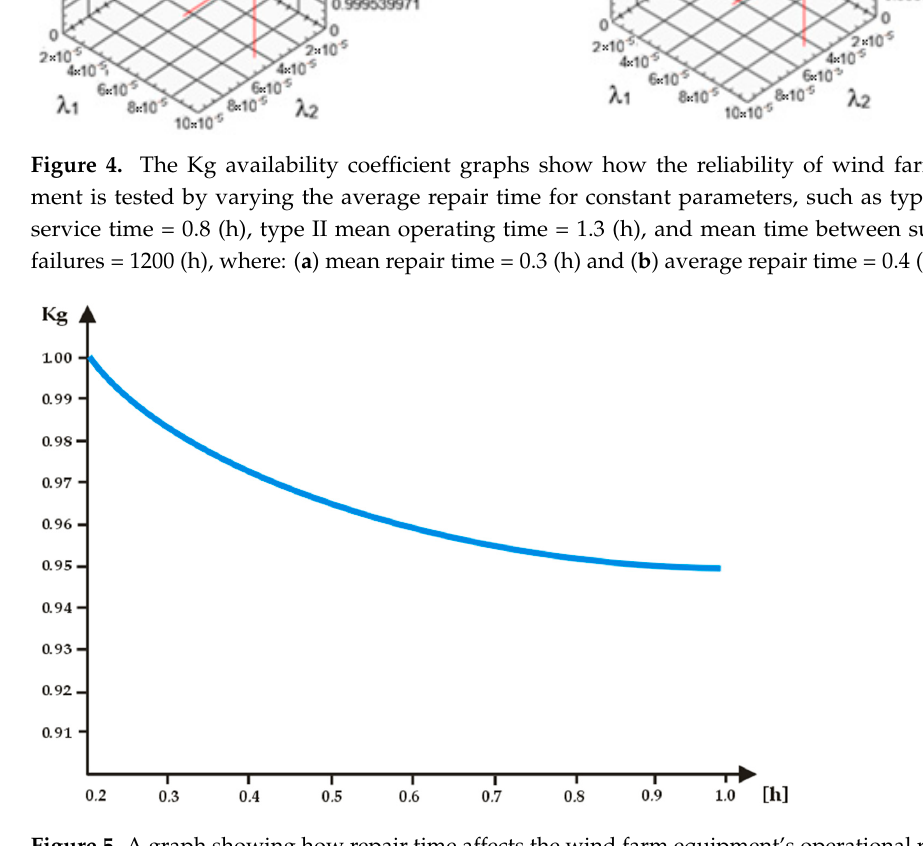
(h), where: ( a ) mean repair time = 0.3 (h) and ( b ) average repair time = 0.4 (h).